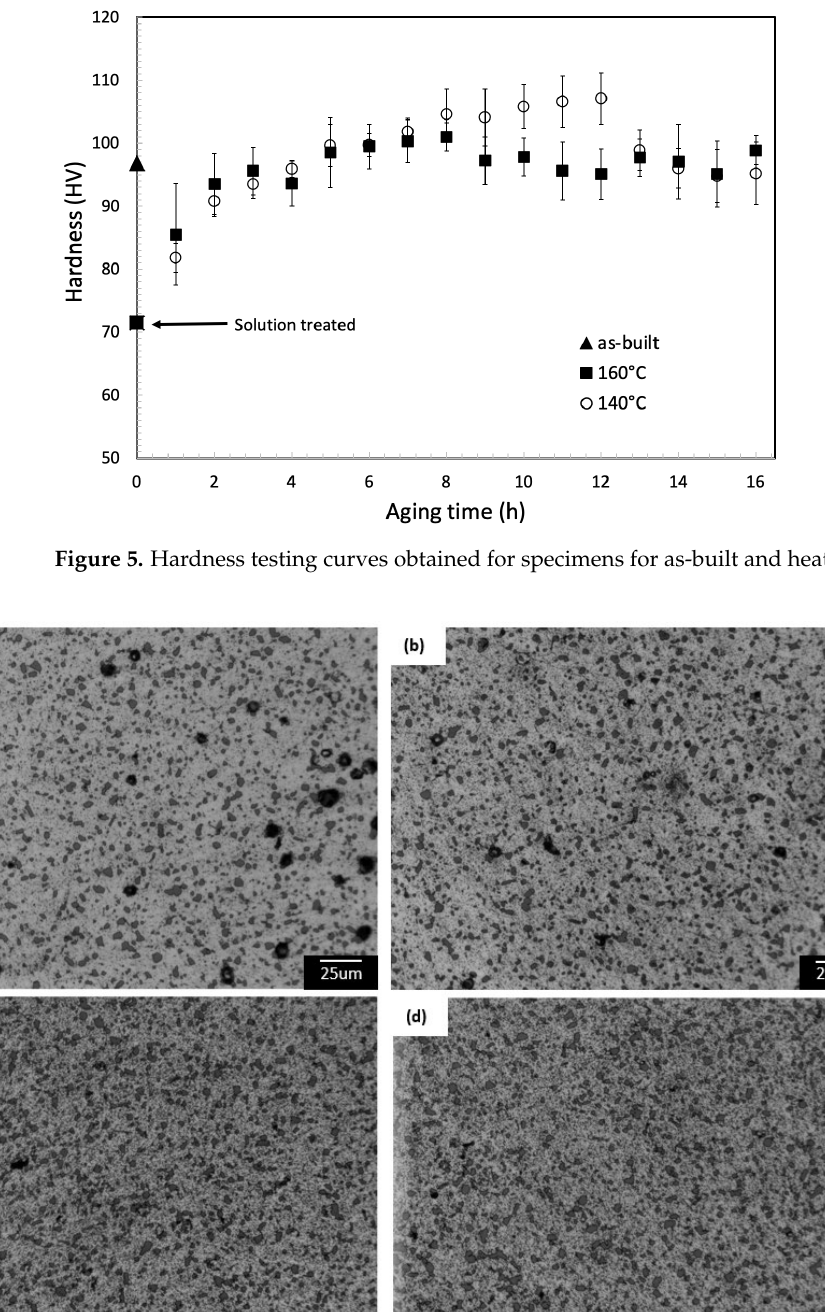
Figure 7. Electron micrographs of specimens ST at ( a ) 540 °C for 6 h and AA at ( b ) 140 °C for 12 h ( c ) 160 °C for 8 h. Room temperature tensile testing was performed on the as-built and heat-treated specimens and the corresponding engineering stress–strain curves and tensile properties are provided in Figure 8 and Table 2, respectively. The mechanical properties of AMed AlSi10Mg are often compared to the as-cast A360 alloy due to the similar composition and they both constitute an Al-Si system with mi crostructures containing α -Al grains in a eutectic Al-Si matrix [24]. In this study, the tensile strength of SLMed AlSi10Mg exhibits a 21.3% increase in yield strength and a 54% increase in elongation at break with a slight decrease in UTS compared to the conventional as-cast A360 tensile strength of 317 MPa [25]. Tensile strength after solution treatment was significantly reduced but the ductility was improved at the same time. Strength decreases upon heat treatment as the Si atoms trapped in the Al matrix are rapidly precipitated out onto the existing eutectic network Si, thus increasing the size of Si precipitates and promoting dislocation bypass in contrast